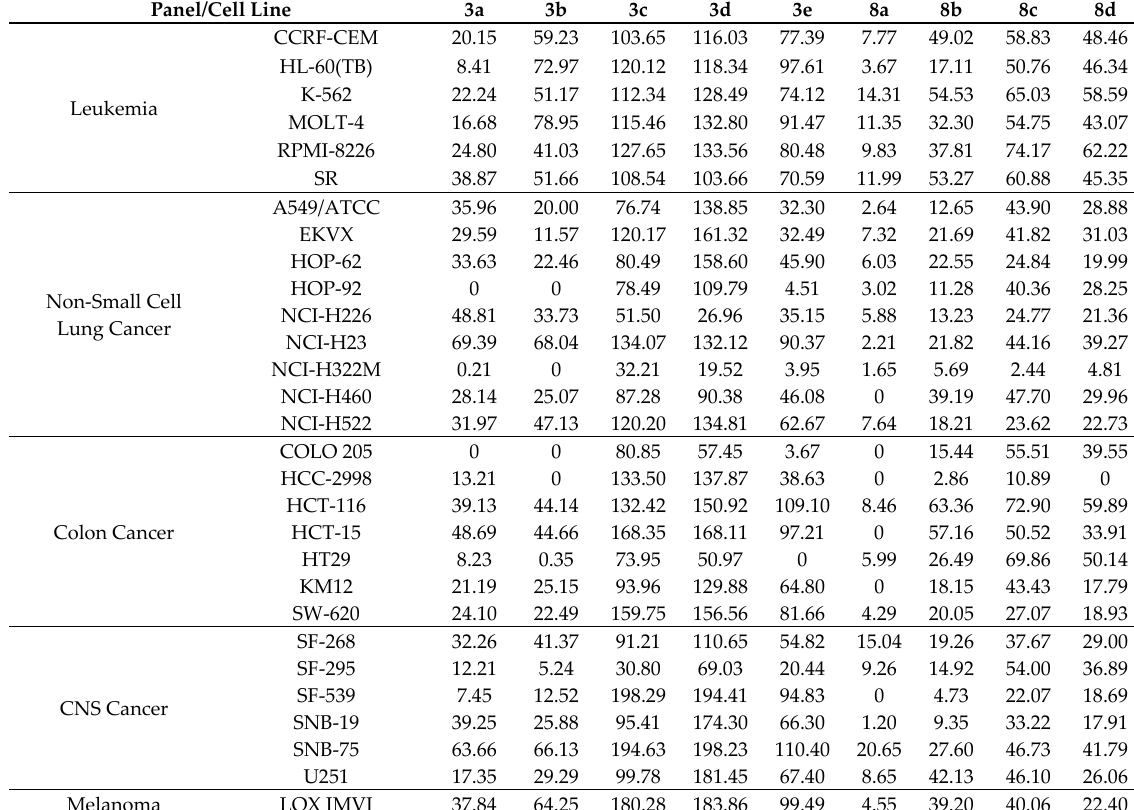
Table 1. Growth percent of compounds 3a – e and 8a – d (at conc. 10 − 5 M) against different cell